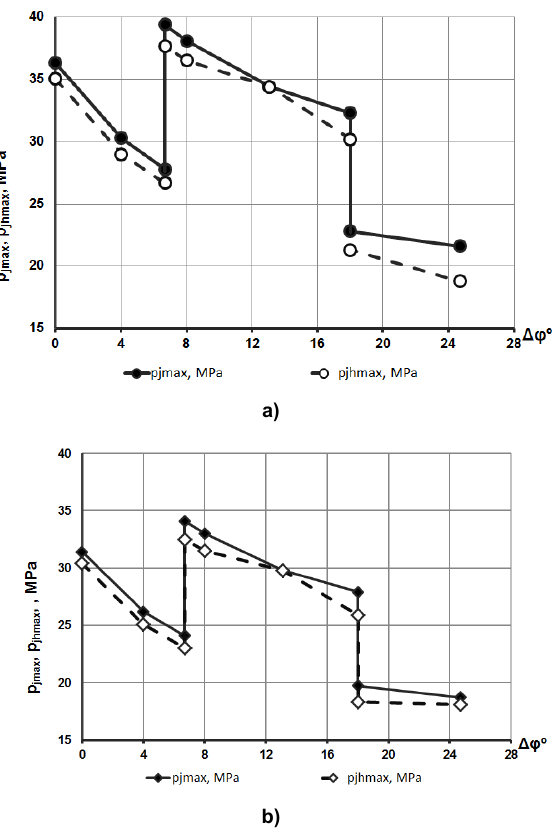
Figure 5. The change of the maximum contact pressures in the process of teeth engagement and wear in MP gear trains: a) Steel - PA6 + 30CF, b) Steel - PA6 +